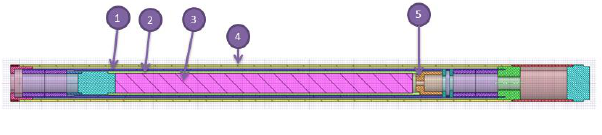
Fig. 2: Geometrical model of the in-core part of the thermostatic